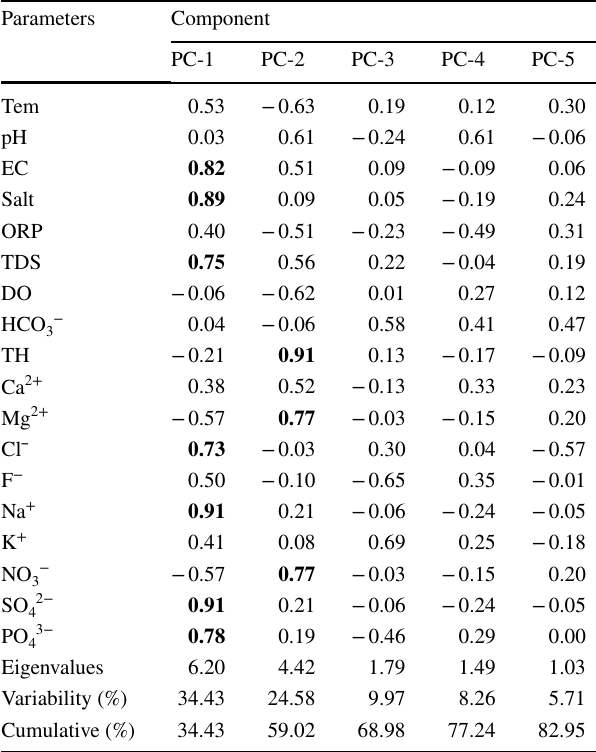
Table 5 Varimax rotated factor loadings with eigenvalues and % of variances for the groundwater quality parameters